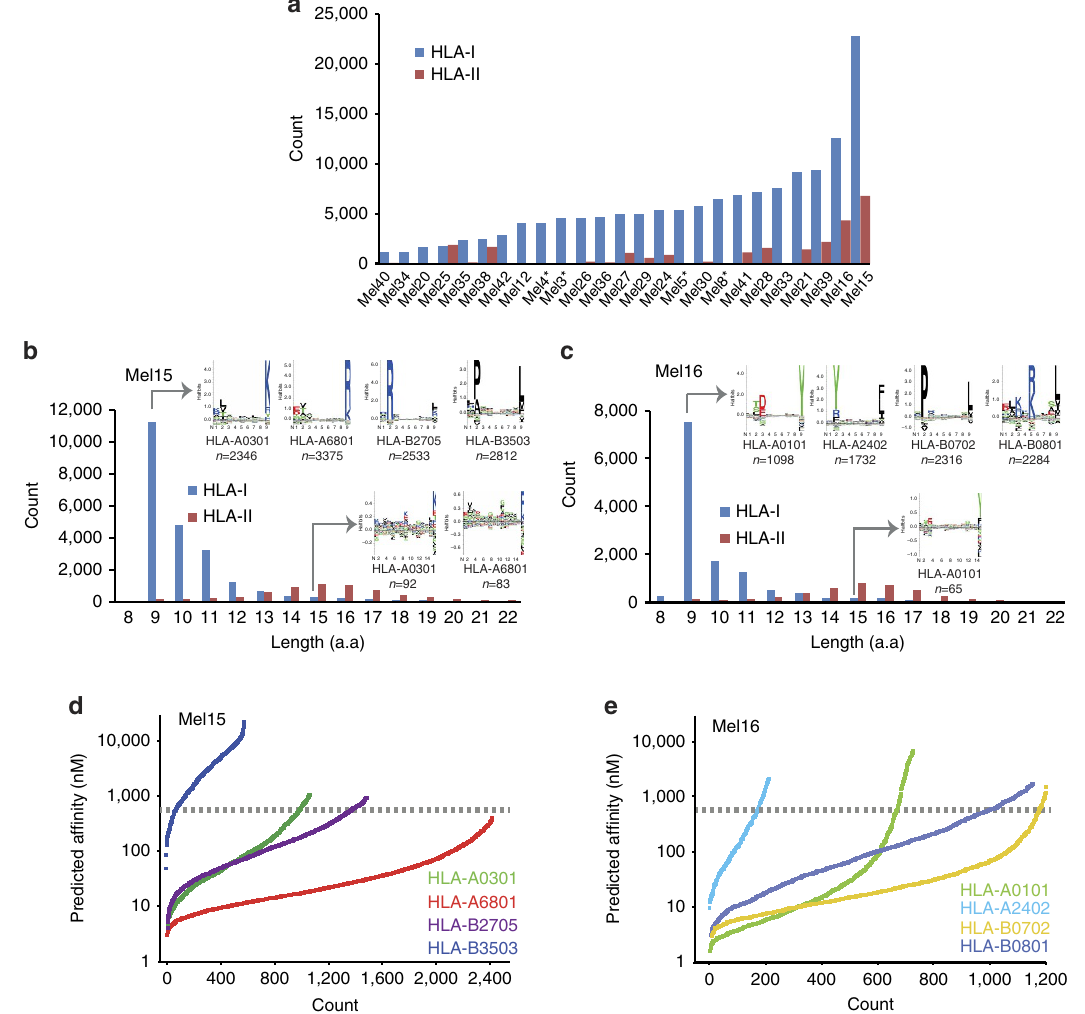
Figure 1 | In depth analysis of the melanoma-associated ligandome. Number of epitopes identified per patient. Asterisk marks samples for which no HLA- II peptidomics have been performed ( a ). Typical length distribution of eluted HLA-I and HLA-II peptides in Mel15 and Mel16. HLA-I peptides clustered to reveal the main binding motifs that fit the patients’ HLA type (Supplementary Table 2) ( b , c ). Predicted affinity of eluted 9-mer peptides from Mel15 and Mel16 using NetMHC ( d , e ) using the threshold of top 2% ranked predicted sequences. The grey line represents the 500nM threshold of binding affinity. detected in both classes I and II peptidome samples (Fig. 2a,b).